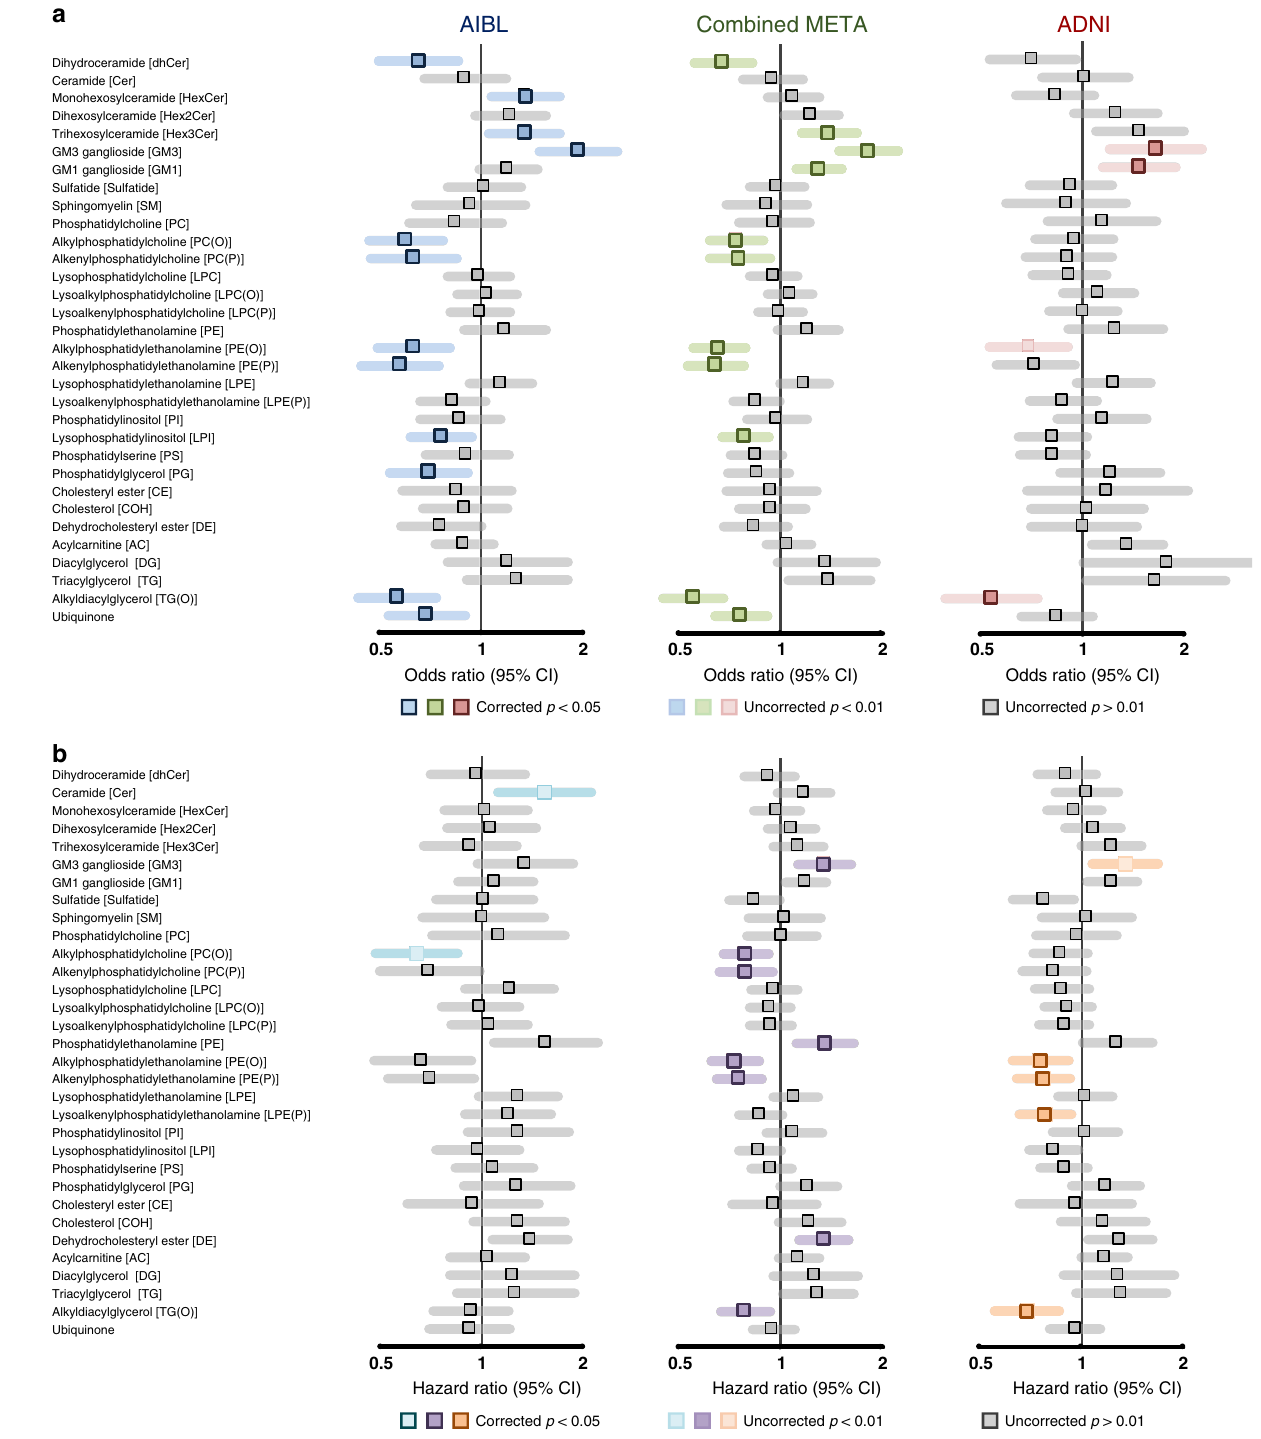
Fig. 2 Associations of lipid class totals with prevalent and incident Alzheimer ’ s disease. Forest plots of lipid class associations for a prevalent Alzheimer ’ s disease (logistic regression, AIBL = 268 cases, 696 control, ADNI = 178 cases, 210 controls) and b incident Alzheimer ’ s disease (Cox regression, AIBL = 68 cases, 714 controls, ADNI = 166 cases, 397 controls). Lipid classes are generated by the sum of each individual species measured in each class. Regressions are adjusted for age, sex, BMI, total cholesterol, HDL-C, triglycerides, number of APOE4 alleles, statin use and omega-3 supplementation. AIBL was further adjusted for time points (only in logistic regression analysis) and site of blood collection. ADNI was further adjusted for fasting